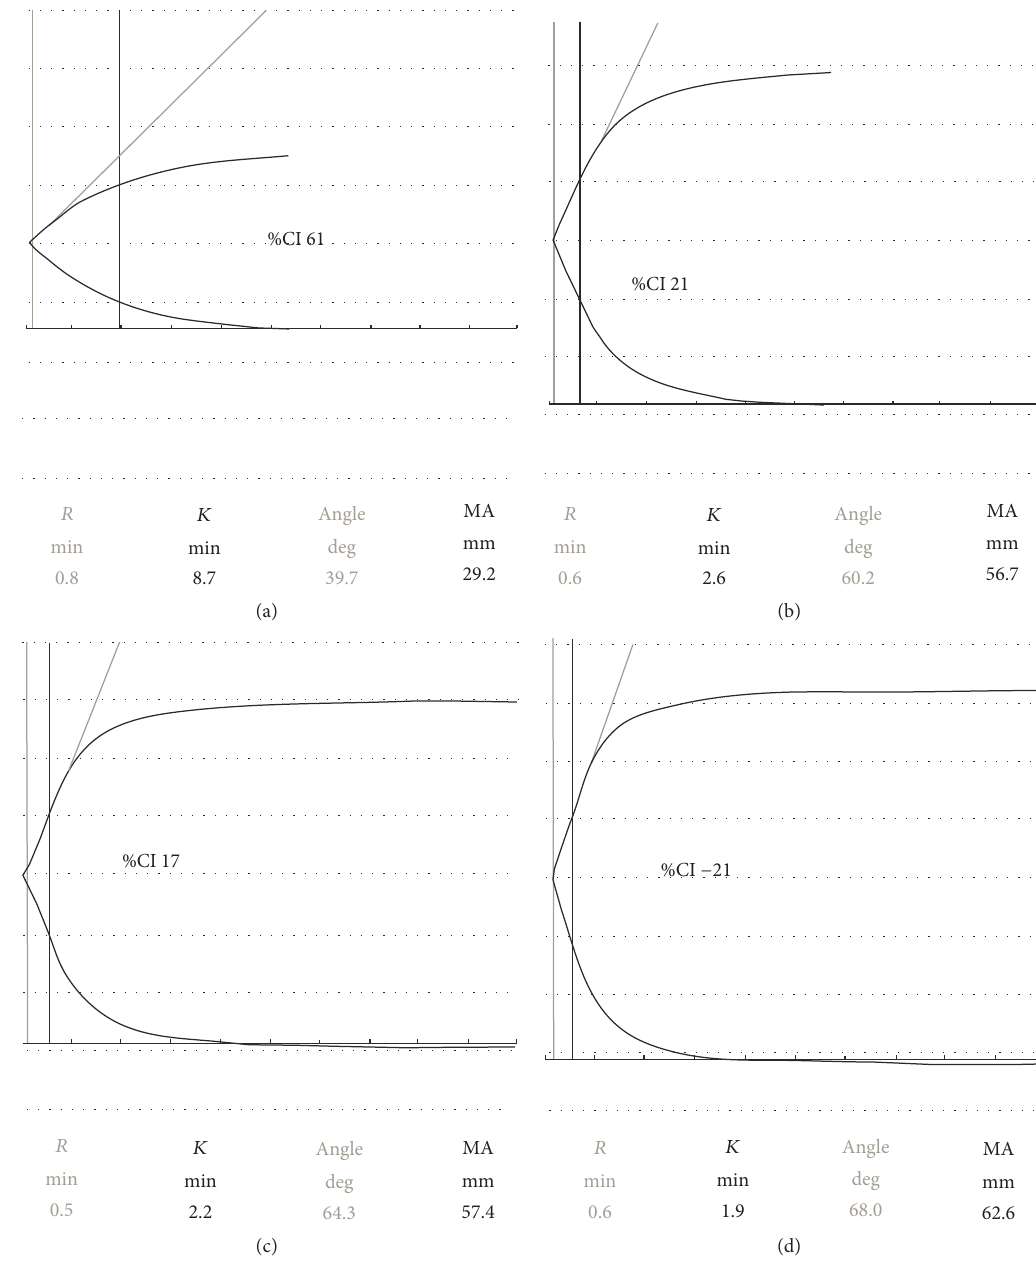
Figure2:Shortthromboelastographytracesshowingadequateresponsetoaspirin75 mgdailyandhyporesponsetoP 2 Y 12